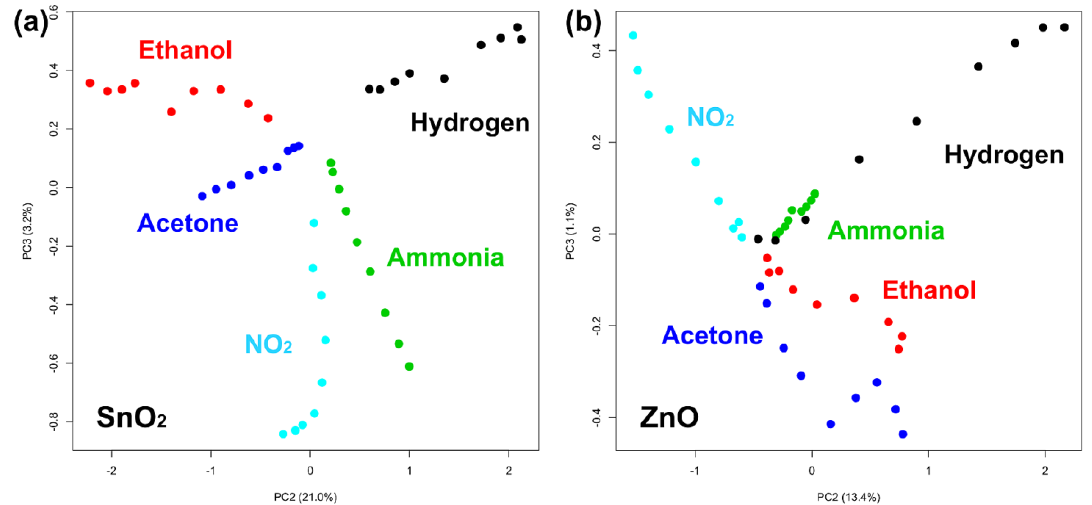
Figure 5. PCA plots showing measurements of the five gases obtained with ( a ) the sensor based on SnO 2 nanowires and ( b ) the sensor based on ZnO nanowires.